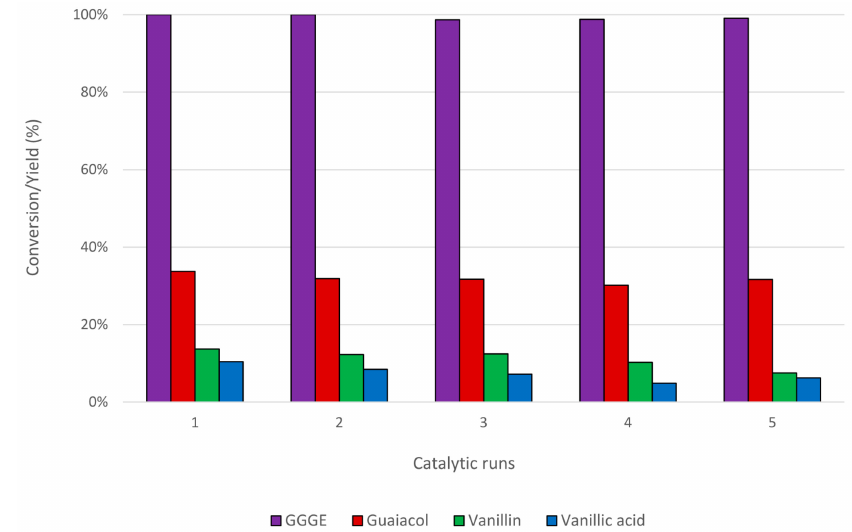
Figure 6. Reuse of 5 wt.% Ru / Al 2 O 3 (3) catalyst in five consecutive GGGE oxidation reactions. Reaction conditions: GGGE to catalyst mass ratio = 1.30, 160 ◦ C, 5 bar (20% oxygen in